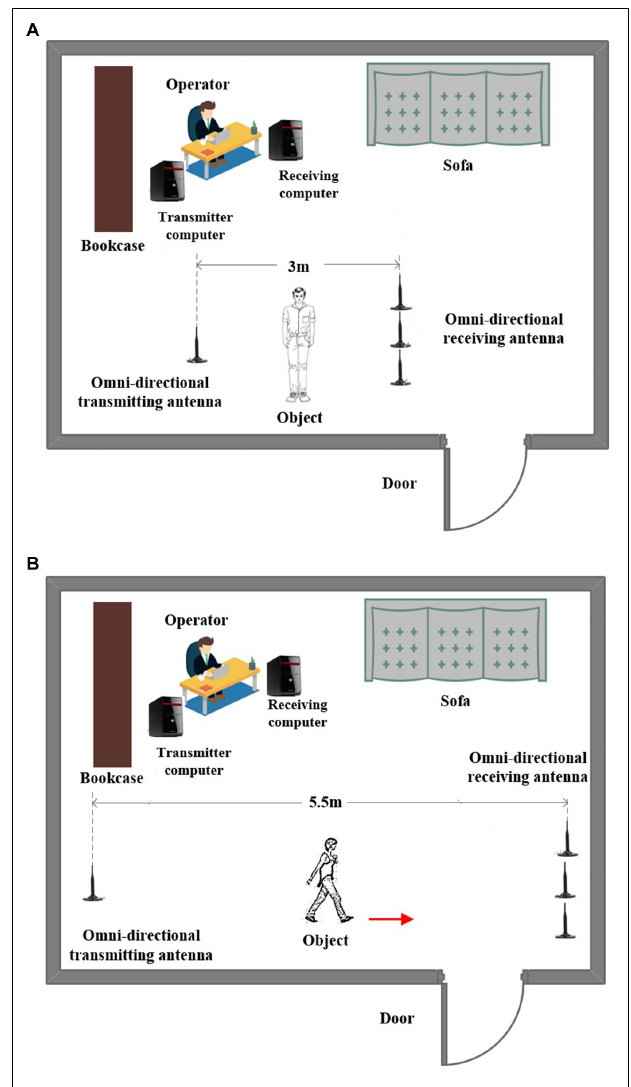
FIGURE 5 | Experiment scene for Romberg’s test and gait measurement. (A) Romberg’s test measurement and (B) gait